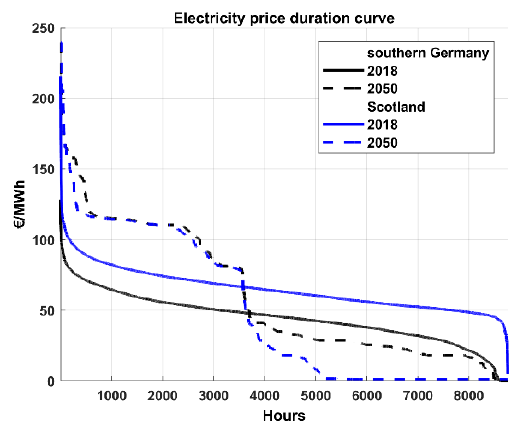
Figure 3. Electricity price duration curves for southern Germany and Scotland in the year 2018 and in the year 2050.